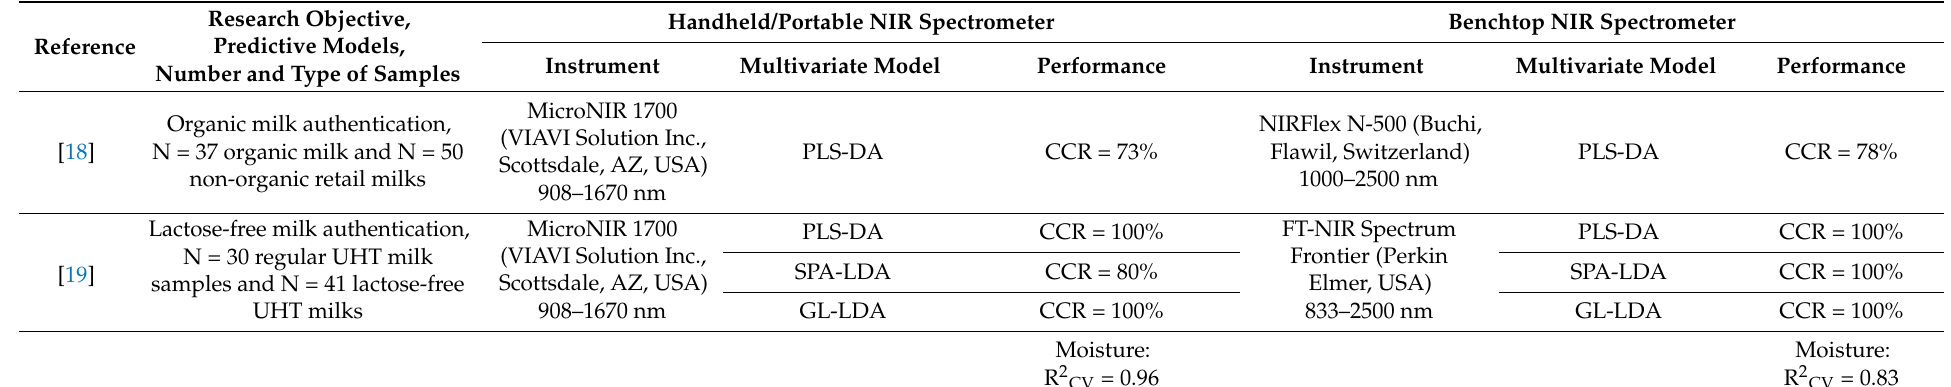
Table 2. Comparison of model performance between handheld/portable NIR instruments and benchtop NIR instruments in the dairy